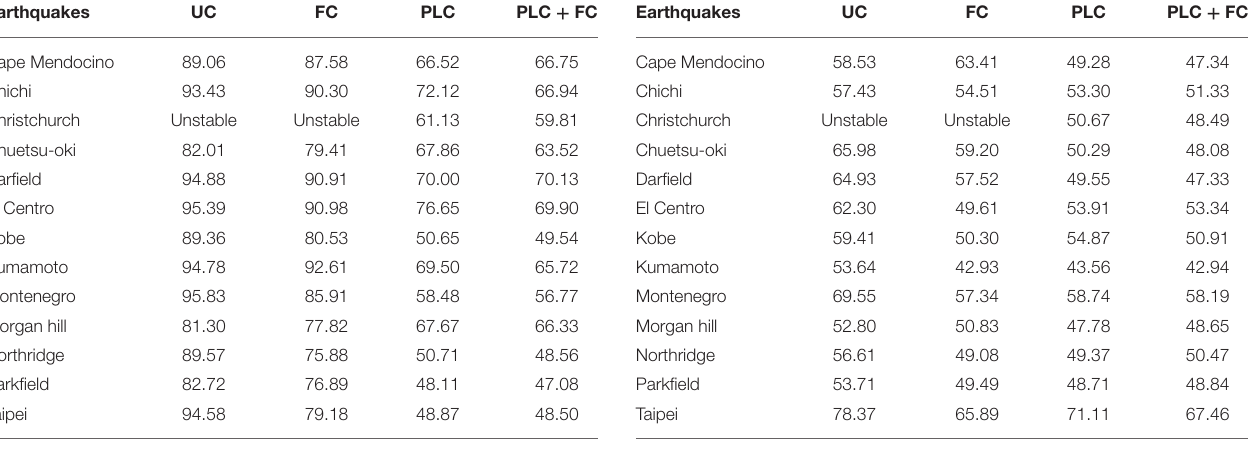
TABLE 3 | RMSE of the superstructure acceleration response with various compensation schemes.